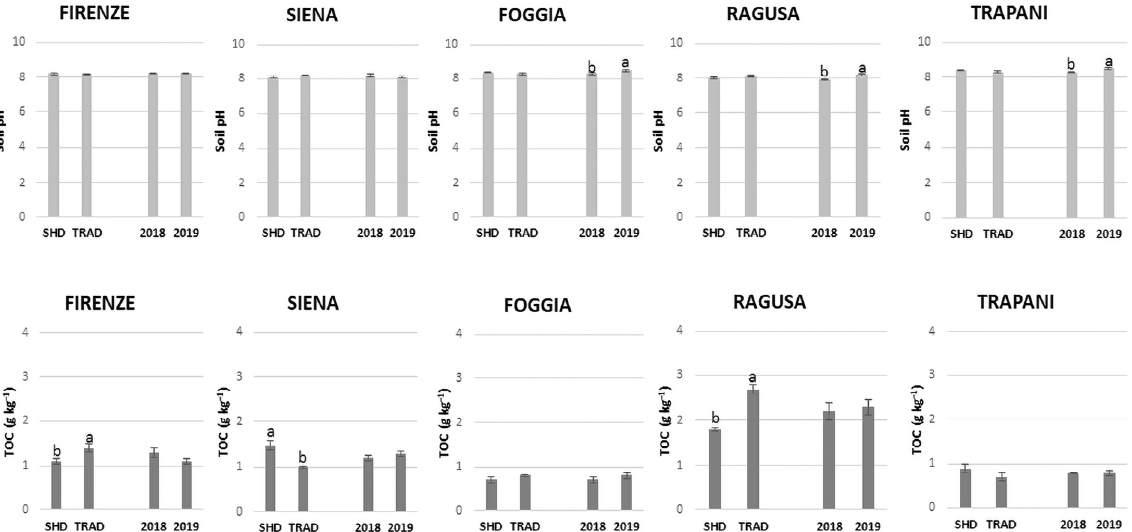
Figure 1. Soil chemical properties: pH and total organic carbon (TOC) of topsoil (0–30 cm) in super- high-density (SHD) and traditional (TRAD) olive orchard systems, in the five experimental sites. Different letters indicate significant differences, p < 0.05, Student–Newman–Keuls test.